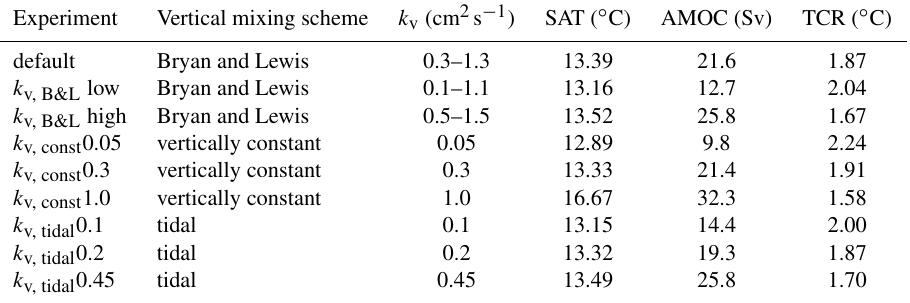
Table 1. Description of different model versions and their names as referred to in the text and figures. k v is the vertical diffusivity. The pre-industrial state of the different model versions is shown for global mean surface air temperature (SAT) and the maximum of the Atlantic meridional overturning stream function (AMOC). The transient climate response (TCR) is calculated as GMSAT change averaged over a decade centred around year